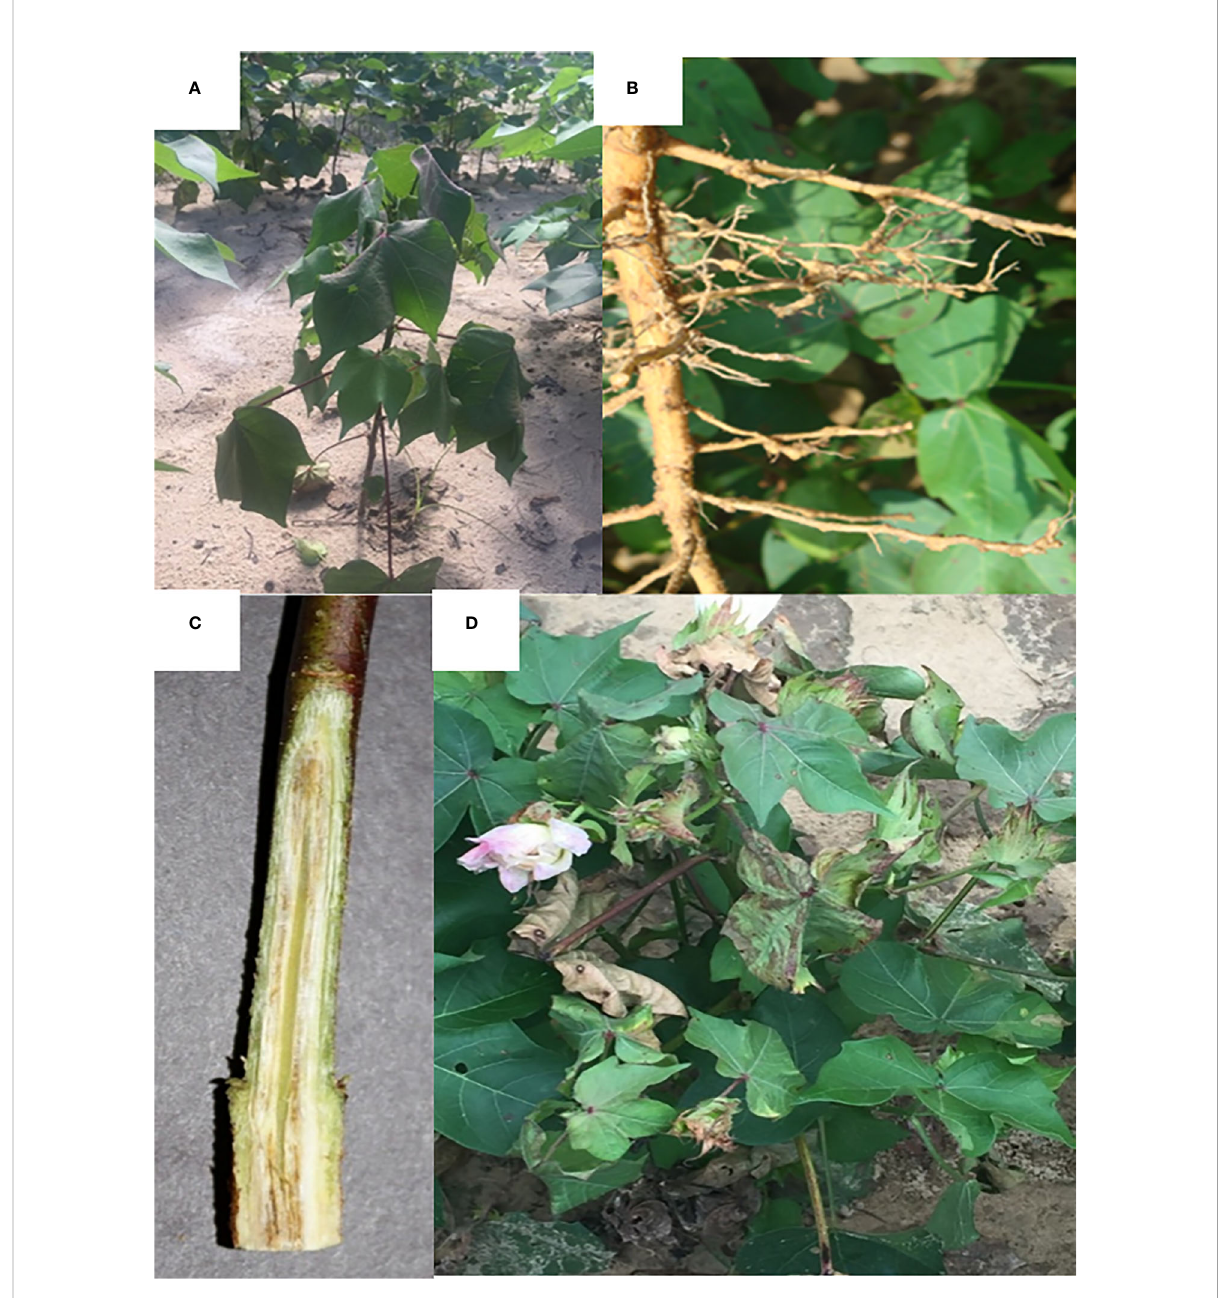
FIGURE 1 Signs and symptoms of Fusarium wilt on Gossypium hirsutum . (A) Wilting of cotton plant caused by Fusarium wilt infection. (B) Meloidogyne incognita galls on cotton roots. (C) Discoloration of the vascular tissue of a cotton stem. (D) Leaf necrosis and wilting caused by Fusarium